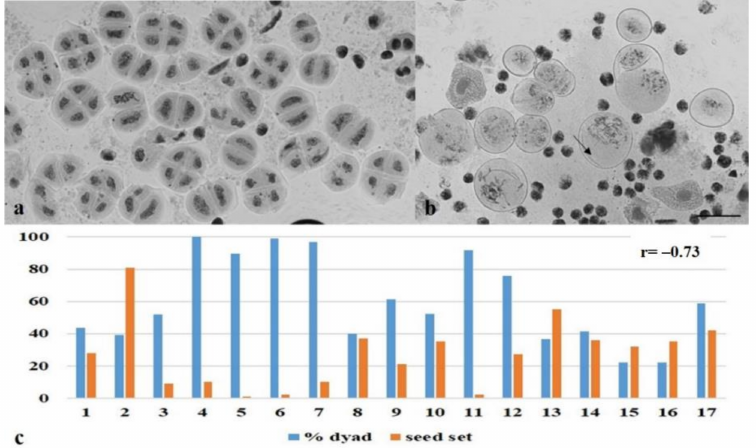
Figure 20. Dyad formation in plants of Group 3. ( a ) Dyads amid tetrads; ( b ) abnormal pollen grain development; meiocytes at the leptotene stage amid pollen grains (shown with an arrow); ( c ) The frequency of dyad formation inversely correlates (r = − 0.73) with seed set. r—correlation coefficient. Staining acetocarmine. Scale bar = 10 µ